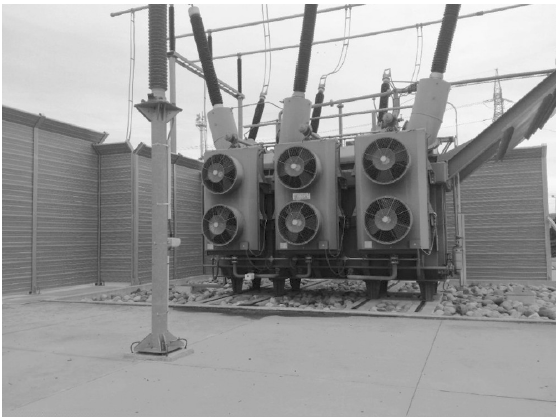
Figure 9. Transformer TR4 surrounded by a noise barrier in the fully validated case.